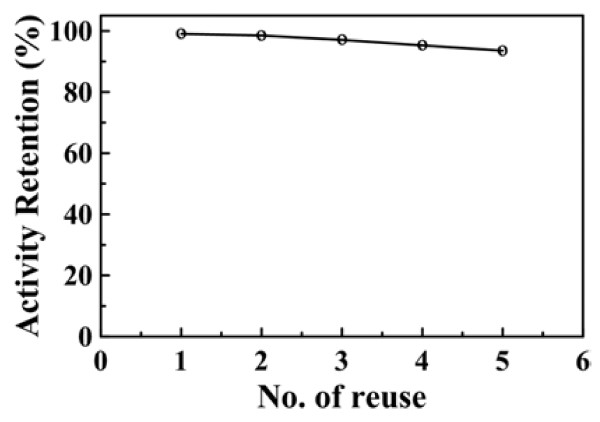
Reusability of GAAu-MNP for the reduction of 4-NP with NaBH4. [Au]0 = 0.295 × 10−2 mg/mL, [4-NP] = 1.5 × 10−4 M, [NaBH4] = 1.5 × 10−2 M, 30°C.